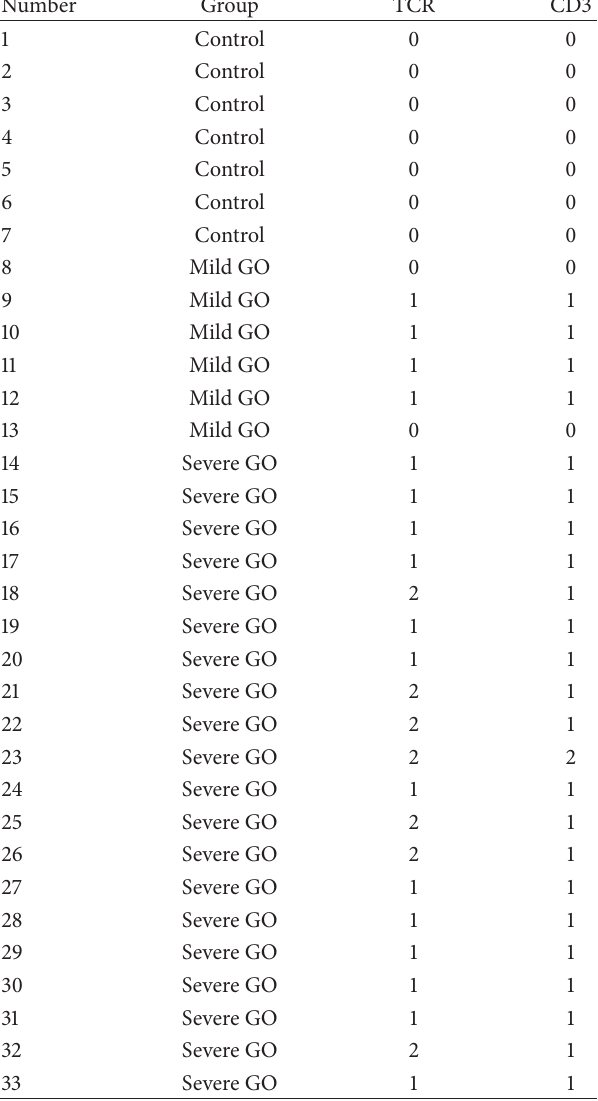
Legend for Table 2: Immunohistochemistry scores are as follows: 0: less than 10% positive in 10 representative high power fields (HPF), 1: 11%–50% positive cells in 10 HPF, 2: more than 50% positive cells in 10 HPF. Immunohistochemistry was done using DAB chromogen (brown